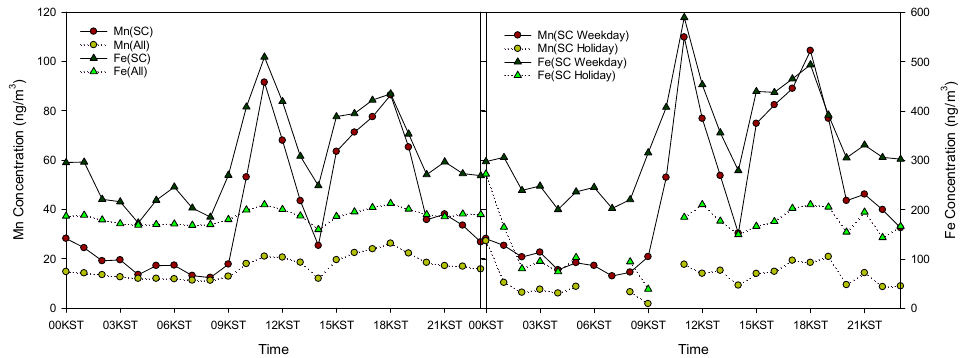
Figure 13. Changes in iron (Fe) and manganese (Mn) concentrations over time.